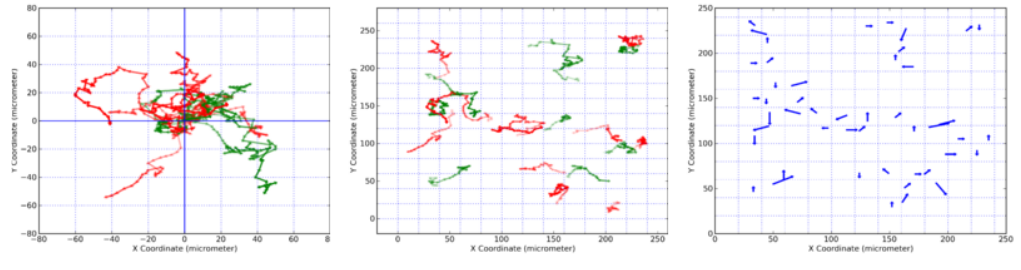
Figure 9: Image time sequences and analysis: (a) Image sequences showing the tracks overlayed on the moving cells. (b) Example visualization methods for superposed tracks: (left panel) center shifted tracks; (middle panel) unshifted tracks; and (right panel) time-average track directions per